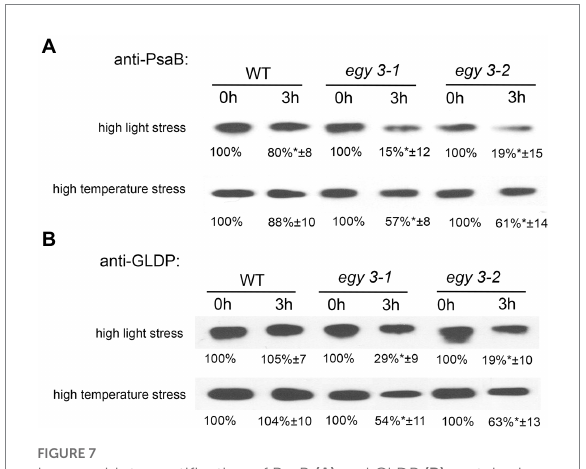
FIGURE 7 Immunoblot quantification of PsaB (A) and GLDP (B) proteins in wild-type (WT) and egy3-1 and egy3-2 mutant plants under high light and high-temperature conditions. Plants were exposed to 1,000 μ mol m − 2 s − 1 (high light) or 40 ° C (high temperature) for 0 and 3 h. Total protein (6 μ g) was immunologically analyzed using an anti-PsaB and anti-GLDP antibodies. GelixOne software was used to quantify the protein content. “±” indicates the SD determined in the analysis of samples obtained from three biological replicates, each of which was obtained by isolation of total protein from a minimum of 20 plants.